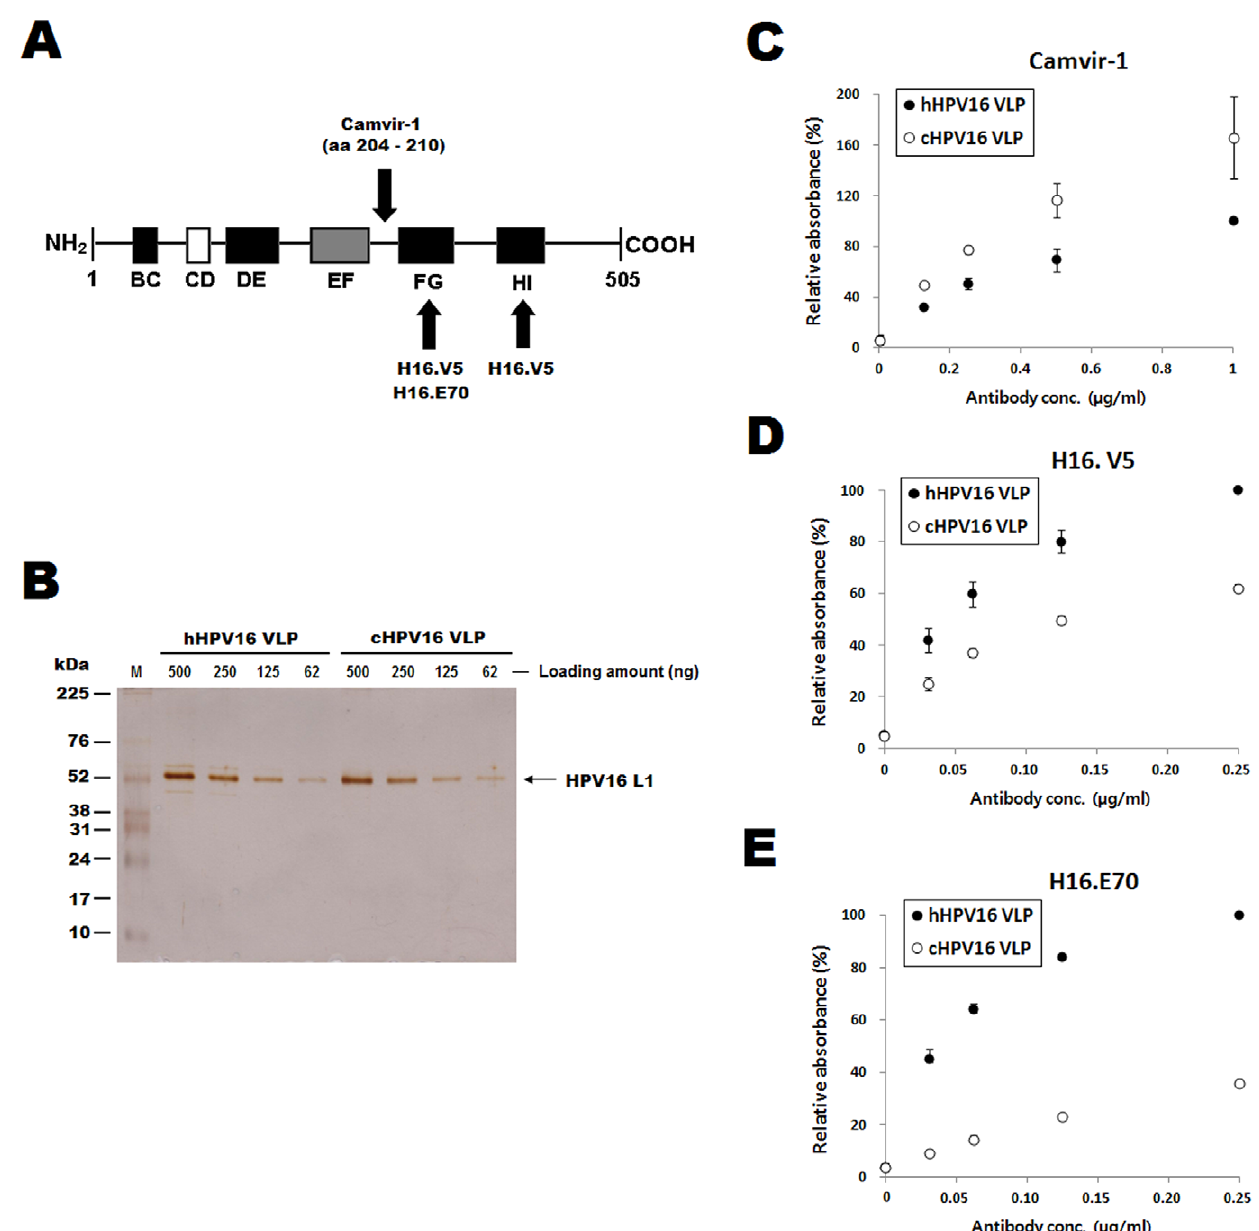
Figure 1. Camvir-1, H16.V5 and H16.E70 reactivity towards hHPV16 VLPs and cHPV16 VLPs. The HPV16 L1 protein residues recognized by H16.V5, H16.E70 and Camvir-1 are displayed graphically in (A). BC, CD, DE, EF, FG and HI indicate the loop structures in HPV16 L1. The numbers refer to the amino acid residues as counted from the N-terminus, the black boxes indicate loops covering the solvent-exposed face of the capsid, and the white box (CD) indicates an internal loop. The gray box (EF) indicates a loop partly located on the outside of the capsid. The hHPV16 VLP and cHPV16 VLP concentrations were confirmed by SDS-PAGE prior to running ELISAs (B). The protein concentration of each VLP preparation was determined by Bradford protein assay, and 500 to 62 ng of proteins were loaded for SDS-PAGE analysis. M indicates the molecular weight marker. Camvir-1, H16.V5 and H16.E70 reactivity towards hHPV16 VLPs and cHPV16 VLPs was determined by direct ELISA. The ELISA results are presented in C, D and E, respectively. The ODs of the hHPV16 VLPs after reaction with 1 m g/ml of Camvir-1, 0.25 m g/ml of H16.V5 and 0.25 m g/ml of H16.E70 were set at 100% in C, D and E, respectively. The ELISA values are the means 6 SD of two independent assays.